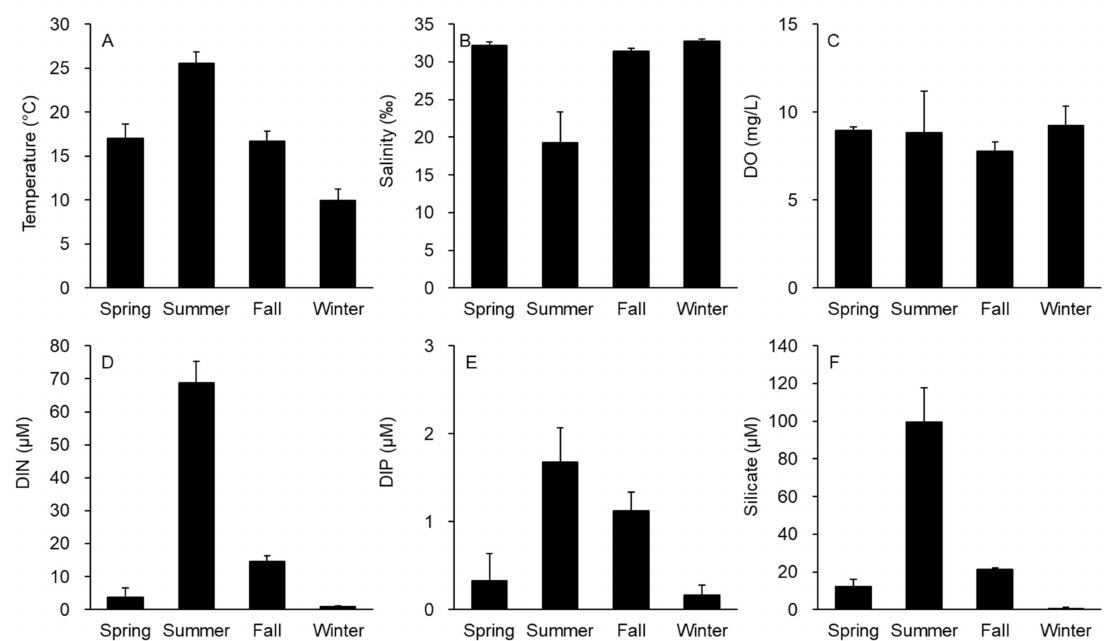
Figure 2. Seasonal variations in environmental variables, including ( A ) temperature ( ◦ C), ( B ) salinity (‰), ( C ) dissolved oxygen (DO; mg/L), ( D ) dissolved inorganic nitrogen (DIN; µ M), ( E ) dissolved inorganic phosphate (DIP; µ M), and ( F ) silicate ( µ M).